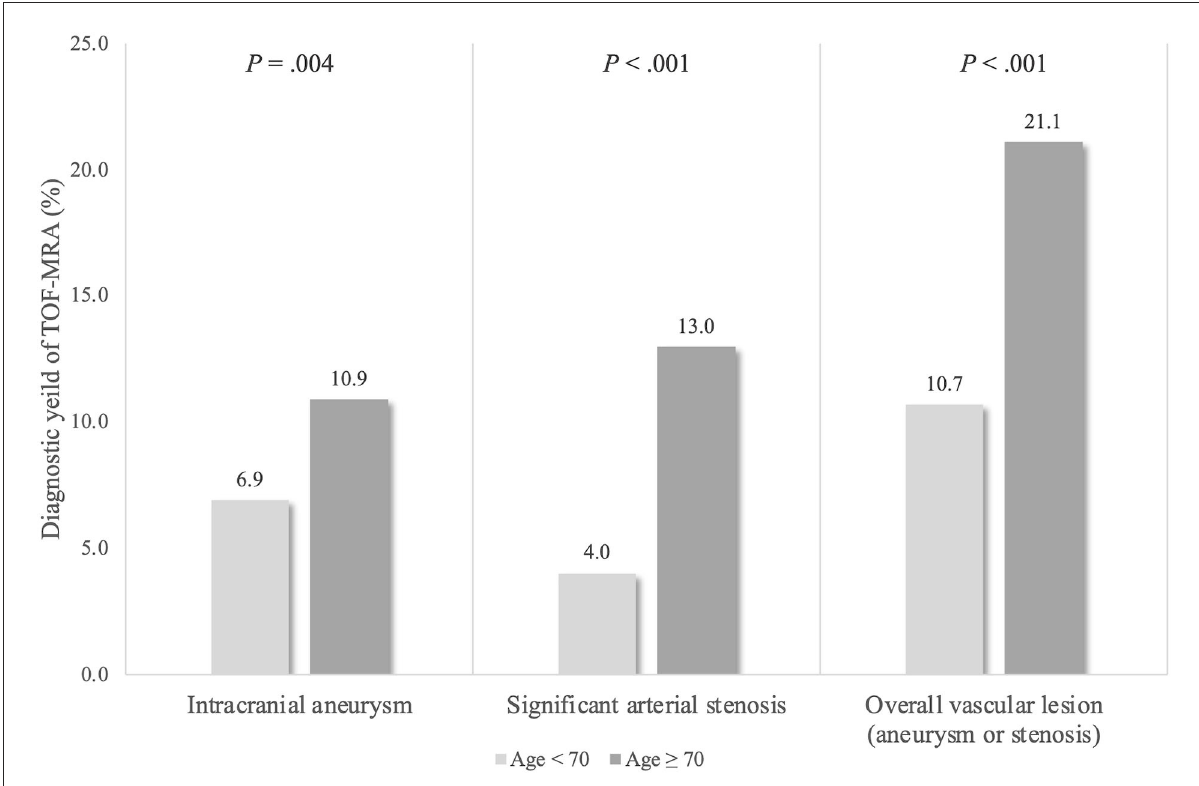
FIGURE4 Diagnostic yield of TOF-MRA for detection of intracranial aneurysm or significant extra- and intracranial artery stenosis based on age stratification. The diagnostic yield of TOF-MRA was significantly higher in patients with age ≥